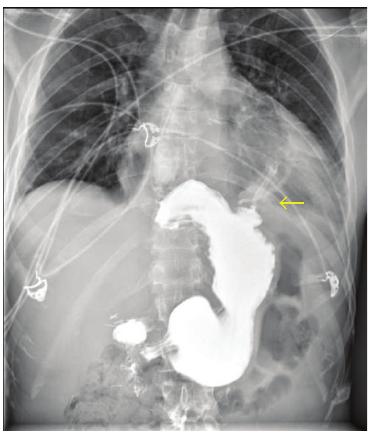
Figure 6: Contrast esophagogram. There is evidence that suggests a fistula located at the level of the